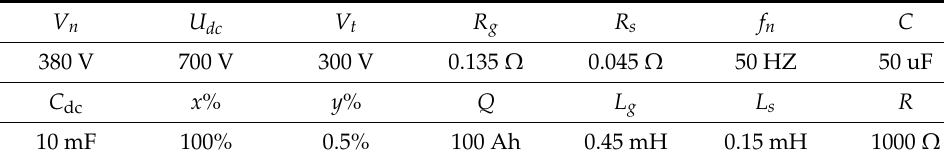
Table 4. Parameters of EVs’ bi-directional